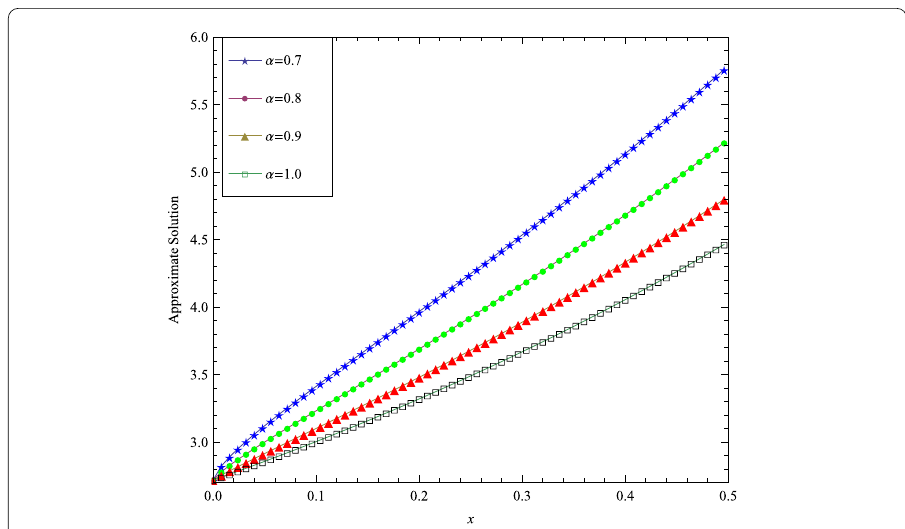
Figure 7 Plot of u ( x , t ) verses x time for different values of λ at t = 1 and (cid:2) = –1